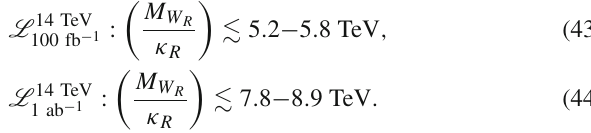
( dash-dot ) and e ± e ± ( solid-triangle ) at 8 TeV and e μ ( dot-star ) at 100 TeV. c , d Sameas a , b ,respectively,butforlowerboundson ( M W All limits are obtained at 95% CL